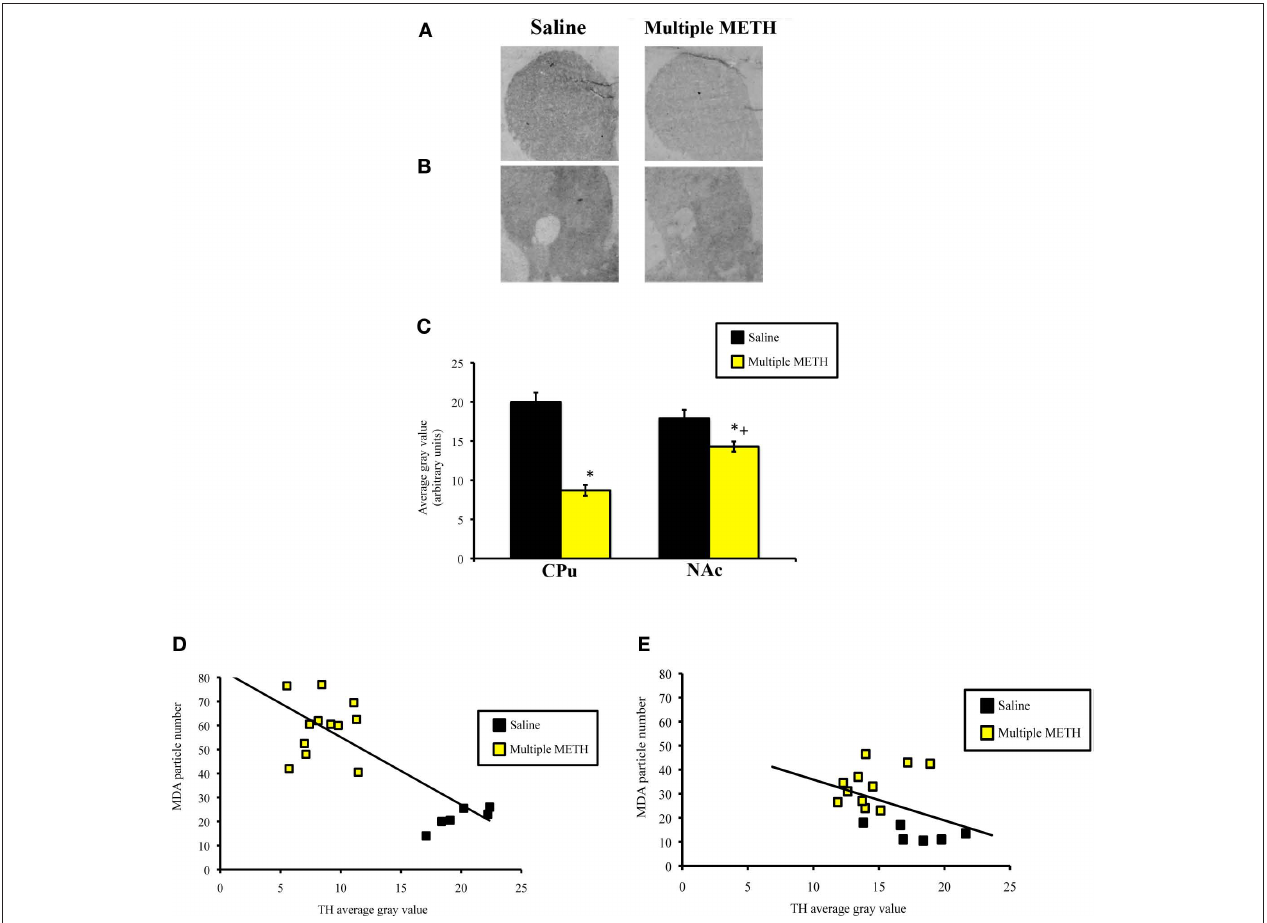
TH-ir in the CPu and NAc, with a significantly greater reduction in TH-ir observed in the CPu vs. NAc of METH-treated animals. There was a significant negative correlation between the total number of MDA-ir particles and the average gray values for TH-ir in the CPu (D) , but not NAc (e) . * p < 0.05 vs. respective saline-treated animals; + p < 0.05 vs. TH-ir in the CPu of METH-treated